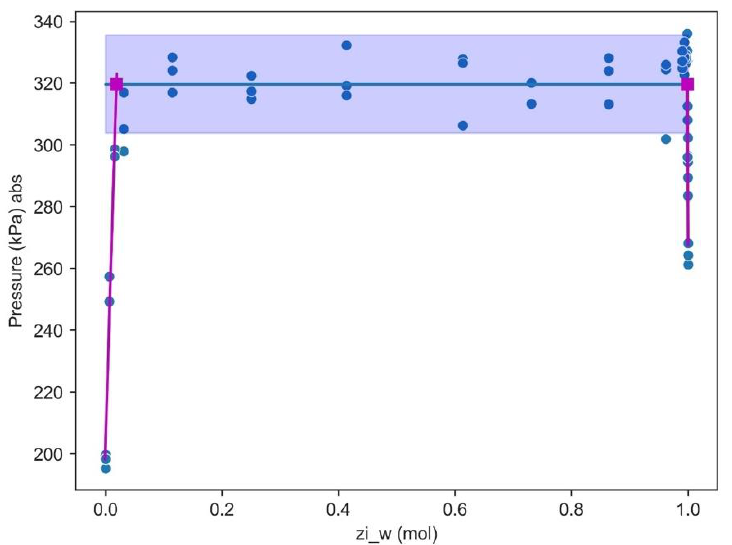
Figure 17. Calculated solubility limit for water/octane at 110 °C. Note: magenta solid lines represent the two-phase region, whereas the blue solid line represents the three-phase region. Blue bands represent the 95% confidence interval.